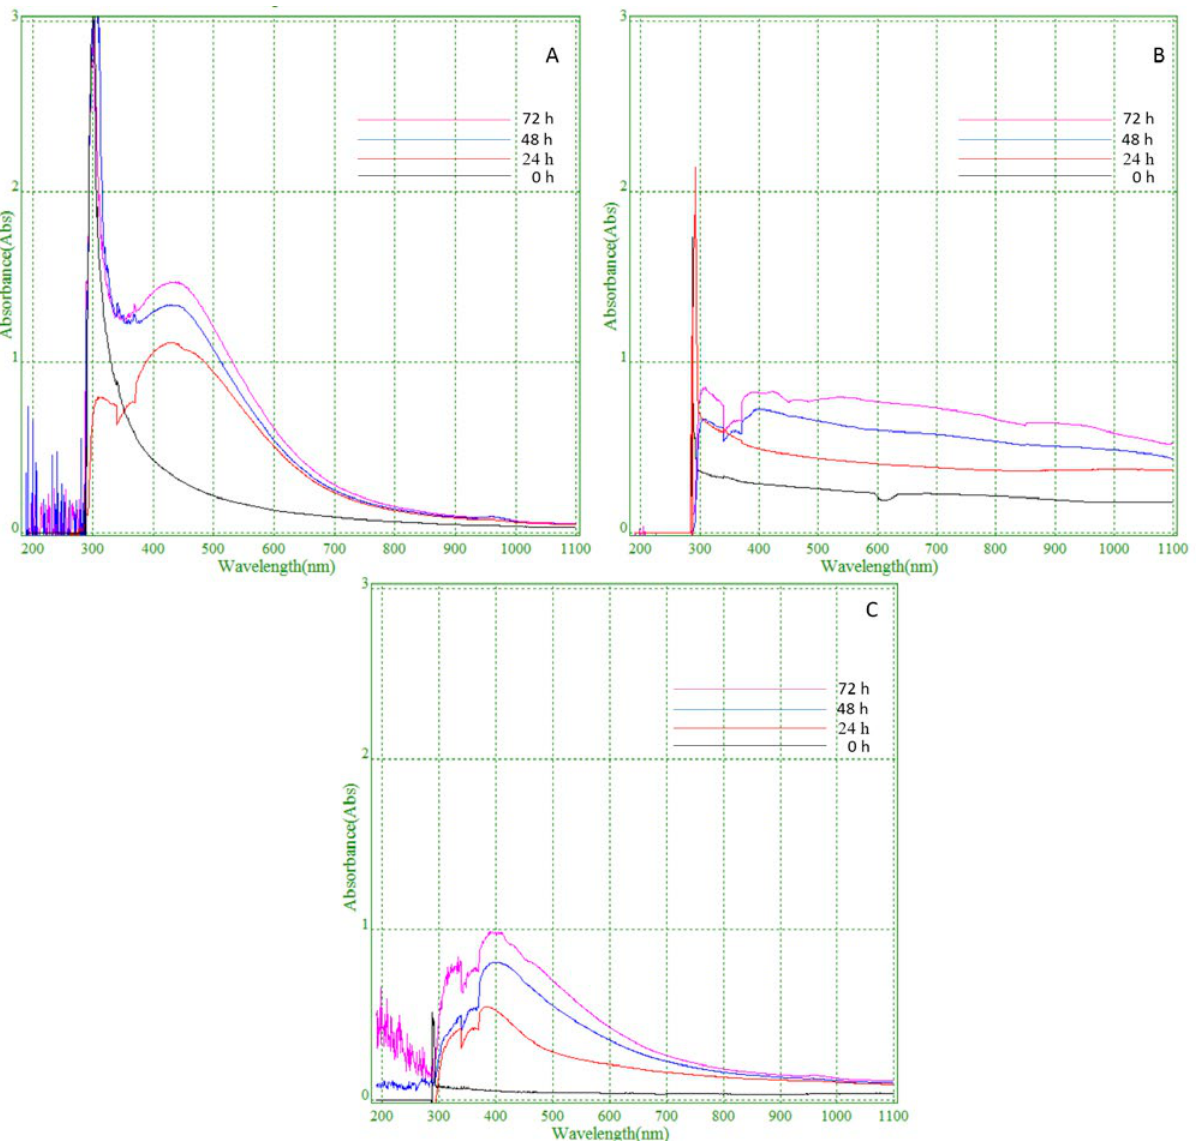
Fig. 1. Examination of intracellular and extracellular synthesis of silver nanoparticles by UV-Vis. A. LAC-AgNPs; B. RAE-AgNPs; C. BAE-